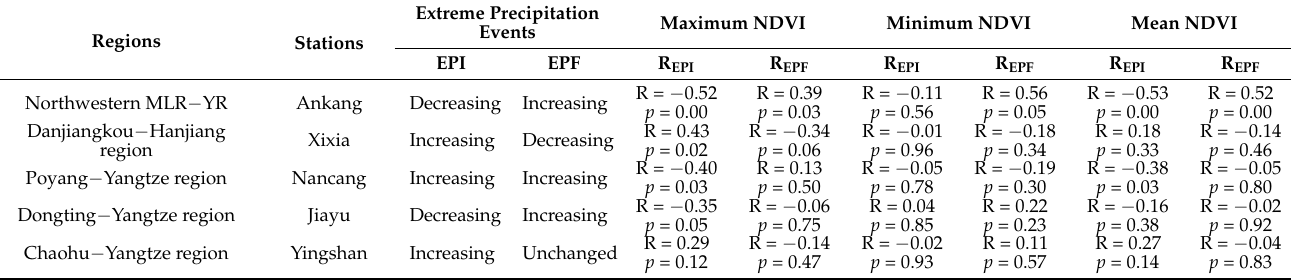
Table 1. The correlations between extreme precipitation indices and different NDVIs in several hotpot stations. Regions